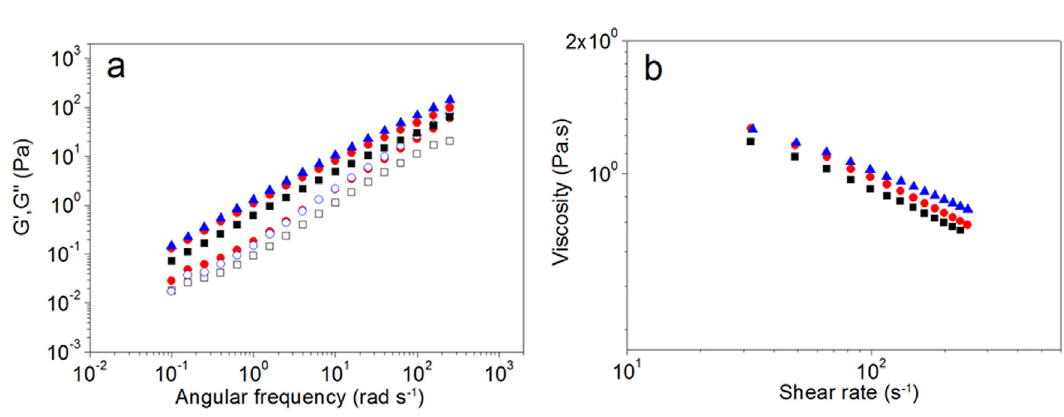
Figure 3. Storage modulus (open symbols) and loss modulus (full symbols) versus oscillation frequency at 25ºC and 5% strain amplitude (a), and viscosity versus shear rate at 25ºC and 5% strain amplitude (b), for the PVA/CS mixed solutions at 70:30 (squares), 75:25 (circles) and 85:15 (triangles) compositions, precursors of M3, M4 and M6